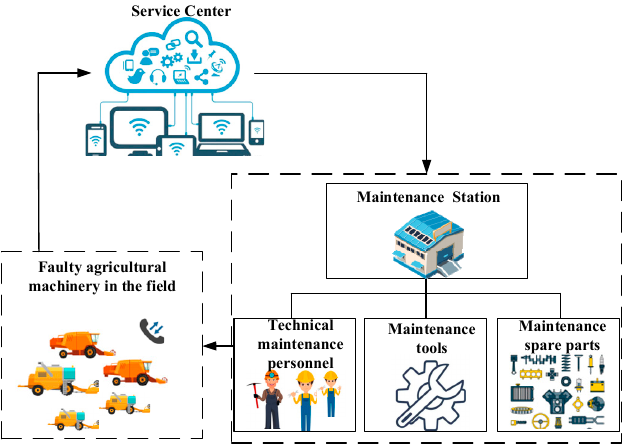
Figure 1. Schematic diagram of the structure of the maintenance service system for cross-regional operations.